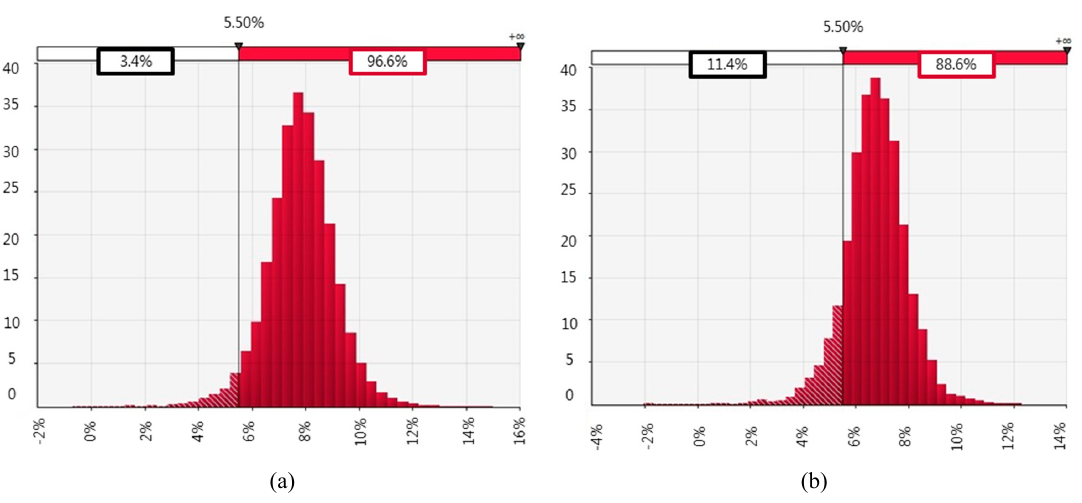
Figure 4. Internal rate of return (IRR) Monte Carlo Analysis ( a ) without SVR and ( b ) with SVR.